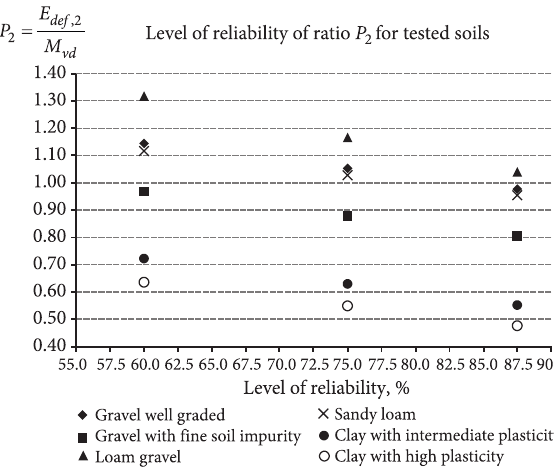
fig. 8. Levels of reliability of obtained ratios of static and dynamic